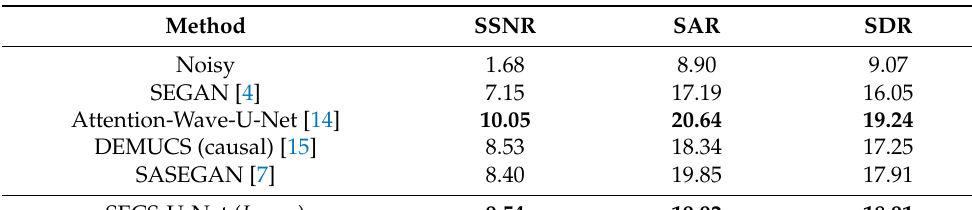
Table 4. SSNR, SAR and SDR of the proposed method and the reference methods (the bold indicates our metric scores and the metric scores that exceed ours in the reference models).